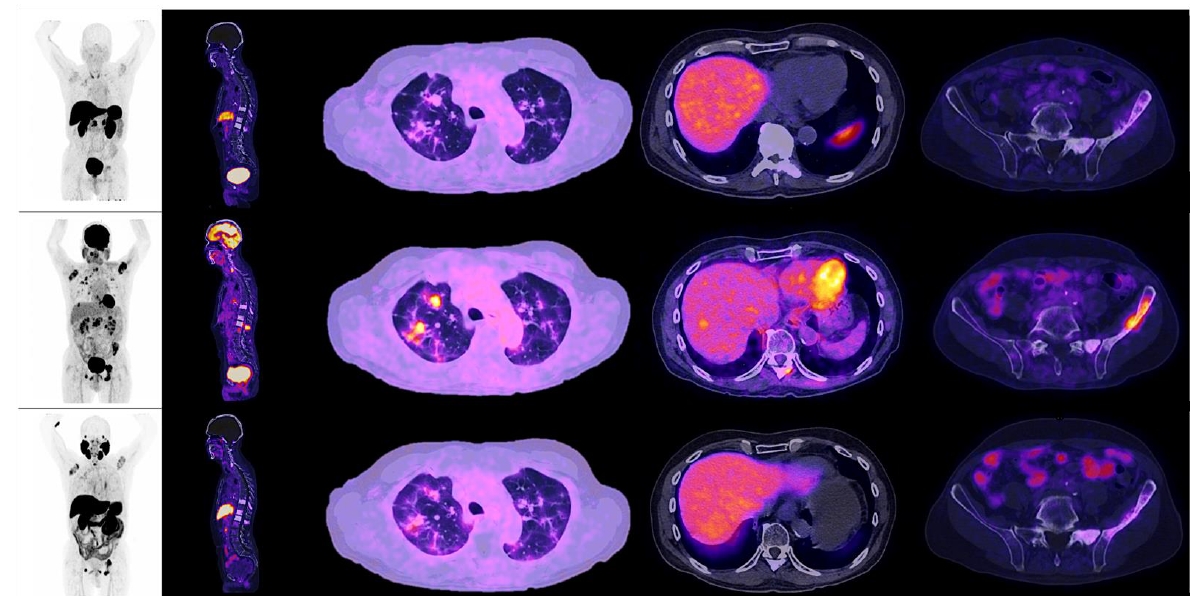
Figure 8. Patient number 3, a 77-year-old male, with an initial histopathological report of prostate adenocarcinoma, Gleason score 9 (4 + 5). Treated with androgen deprivation therapy + chemother- apy. Site of second biopsy was in left iliac bone, with a confirmatory histopathological report of neuroendocrine carcinoma (positive immunohistochemistry for chromogranin and synaptophysin). Time lapse to neuroendocrine differentiation was 48 months, with a PSA value of 0.003 ng/dL at the time of diagnosis. The image shows the maximum intensity projection of the three radiotracers ( 18 F AlF-NOTA-Octreotide, 18 F–FDG and 18 F–PSMA-1007) with multiple lung nodules, a single liver metastasis and osteoblastic lesions with high glycolytic metabolism in molecular